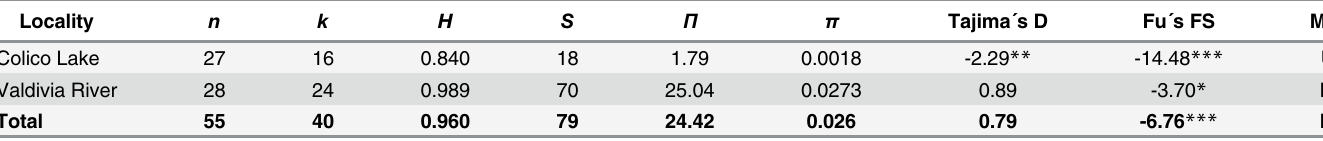
Table 1. Diversity indices, neutrality tests and mismatch distributions in landlocked and migratory populations of Galaxias maculatus . Locality n k H S Π π Colico Lake Total 55 Where: n = analyzed specimens; k = haplotype number; S = polymorphic sites; H = haplotype diversity; Π = average number of nucleotide differences;